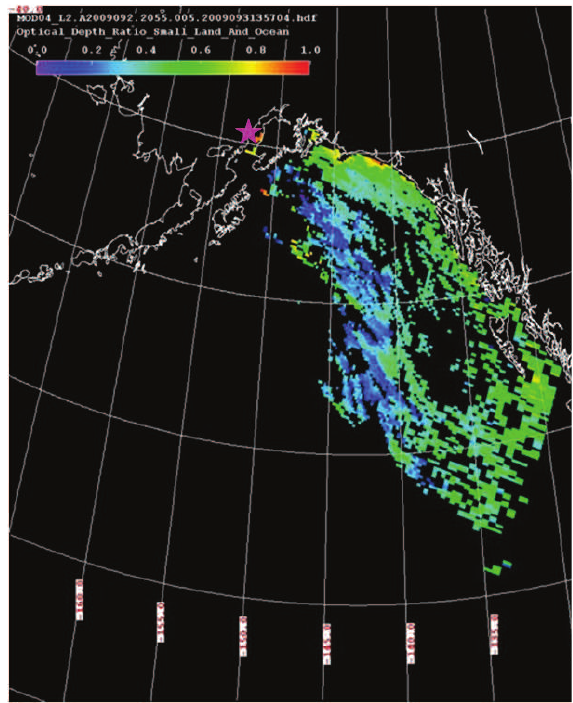
Fig. 5. Terra MODIS fine mode fraction AOD on 2 April at 20:55 UTC. Mt. Redoubt is marked by a star.